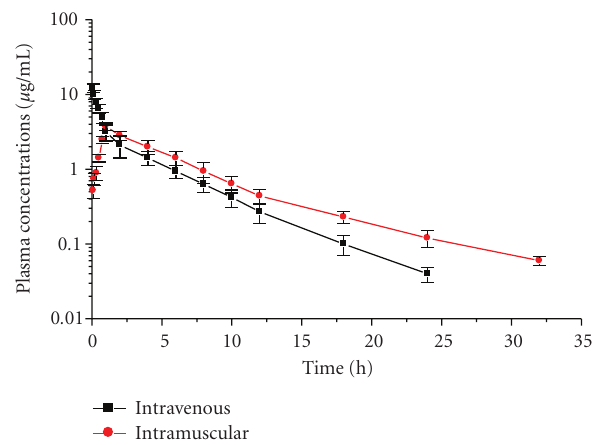
Figure 1: Mean ± SD plasma concentrations of levofloxacin in sheep after intravenous ( (cid:2) ) and intramuscular ( • ) injection of 4mg/kg b.wt. ( n =